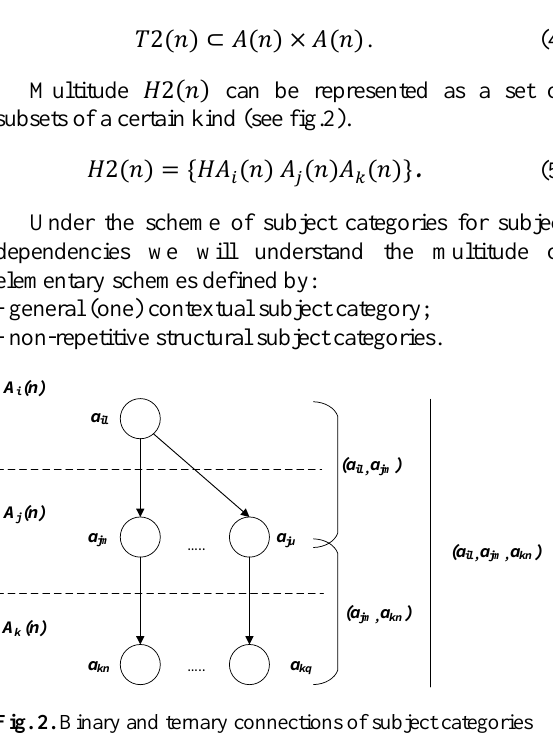
Fig. 2. Binary and ternary connections of subject